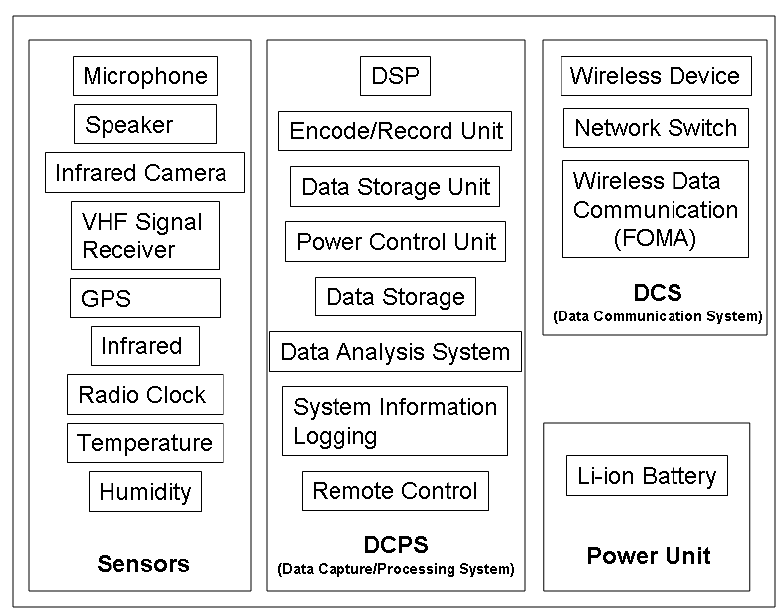
Figure 13. Overview of system